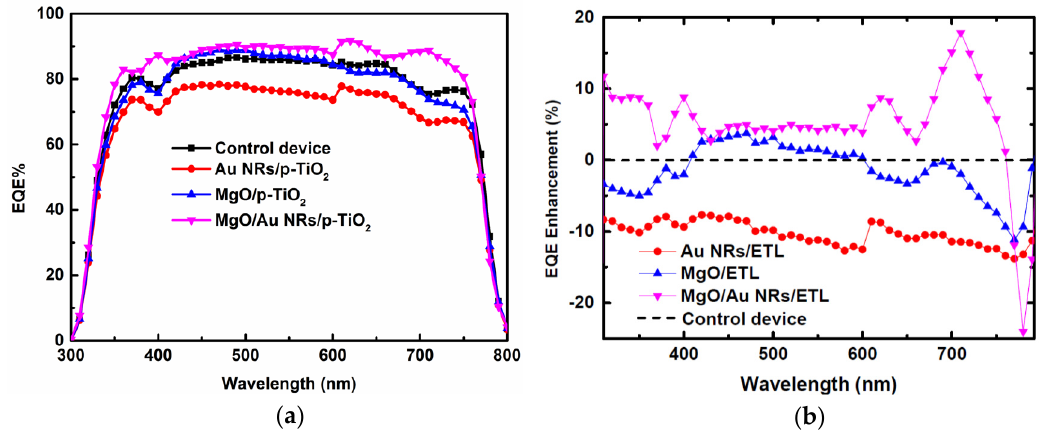
Figure 4. ( a ) External quantum efficiency (EQE) curves of the control (reference) device and the PSCs with Au NRs or MgO overlayer. ( b ) EQE enhancements of PSCs with Au NRs and MgO overlayer: EQE enhancement: Δ EQE/EQE ref ( Δ EQE, the difference between EQE values of the modified and the reference devices).